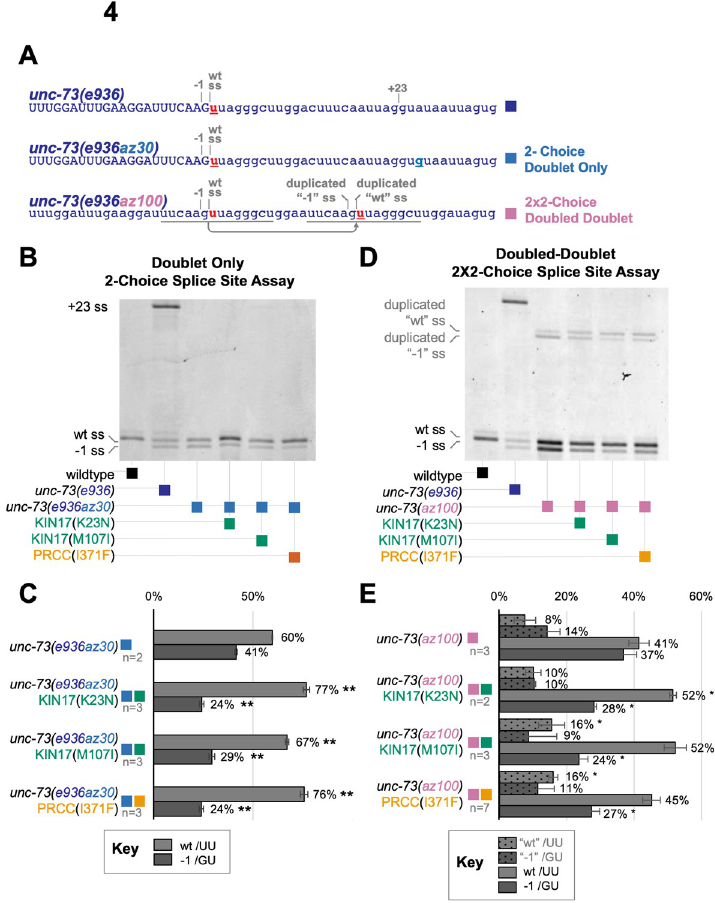
Fig 4. UU/ preference is independent of splice site location. (A) Sequences of three splice site choice competition reporters based on C . elegans unc-73 : the first is the unc-73(e936) allele that allows for three cryptic splice sites as described in Fig 1A; below that, unc-73( e936az30 ) intragenic suppressor allele in which the +23 splice site is abolished by a A ! G at the +26 position of the intron, leaving only the doublet of /G/UU splices sites, which we refer to as the 2-choice doublet-only splicing assay, and unc-73( az100 ) in which the genomic region of the doublet splice site has been duplicated, overwriting the downstream wild-type sequence and creating two /G/UU doublets, 18 bases away from each other, which we refer to as the 2x2 doubled-doublet splicing assay. (B) All three suppressors change the ratio of splice site usage at the doublet, promoting the /UU splice site. Poly-acrylamide gel showing Cy-3 labeled unc-73 PCR products from cDNA. The alleles found in each sample are indicated in the figure. The same PCR primers are used on all samples; band positions and intensities are indicative of relative use of the available 5’ splice sites. (C) Quantification of PSI of the indicated strains. Error bars show Standard Deviation One. Star indicates p-value less than 0.05, and two stars indicate p-value less than 0.005 by Student’s 2-tailed T-test for samples with unequal variances when PSI for that splice site is compared to PSI in unc73(e936az30) control. (D) All three suppressors change the ratios of splice site usage at both the original doublet and the duplicated doublet, promoting the /UU splice site. Poly- acrylamide gel showing unc-73 Cy-3-labeled PCR products from cDNA from the indicated strains with the indicated alleles. (E) Quantification of PSI of the indicated strains; details in Methods. Error bars show Standard Deviation. Star indicates p-value less than 0.05, by Student’s 2-tailed T-test for samples with unequal variances, when PSI for that splice site is compared to PSI in unc73(az100)